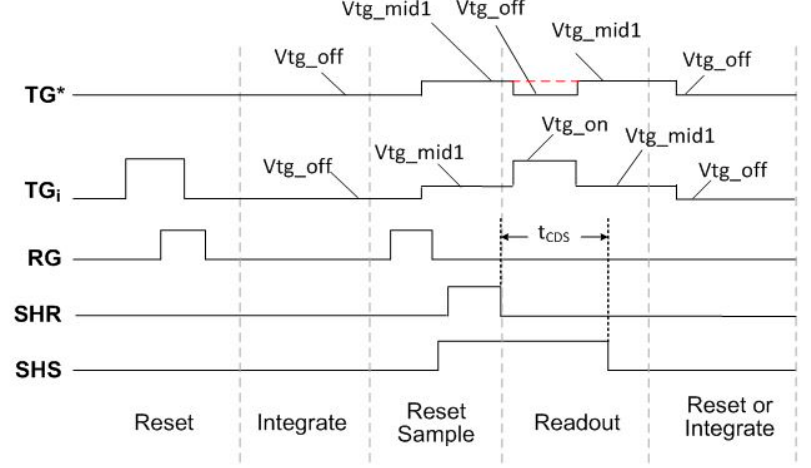
Figure 6. Intended pixel timing diagram for TG feed-through compensation: TGi is the row being readout; TG* is 3 “other” TG’s in the 1 × 4 pixel cell.